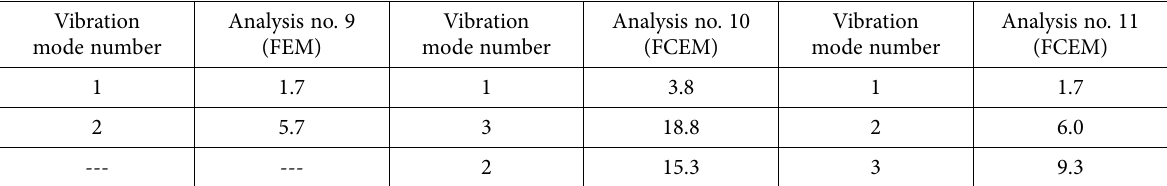
Table 4. Natural frequency values (Hz) obtained with different methods for the studied RC frame